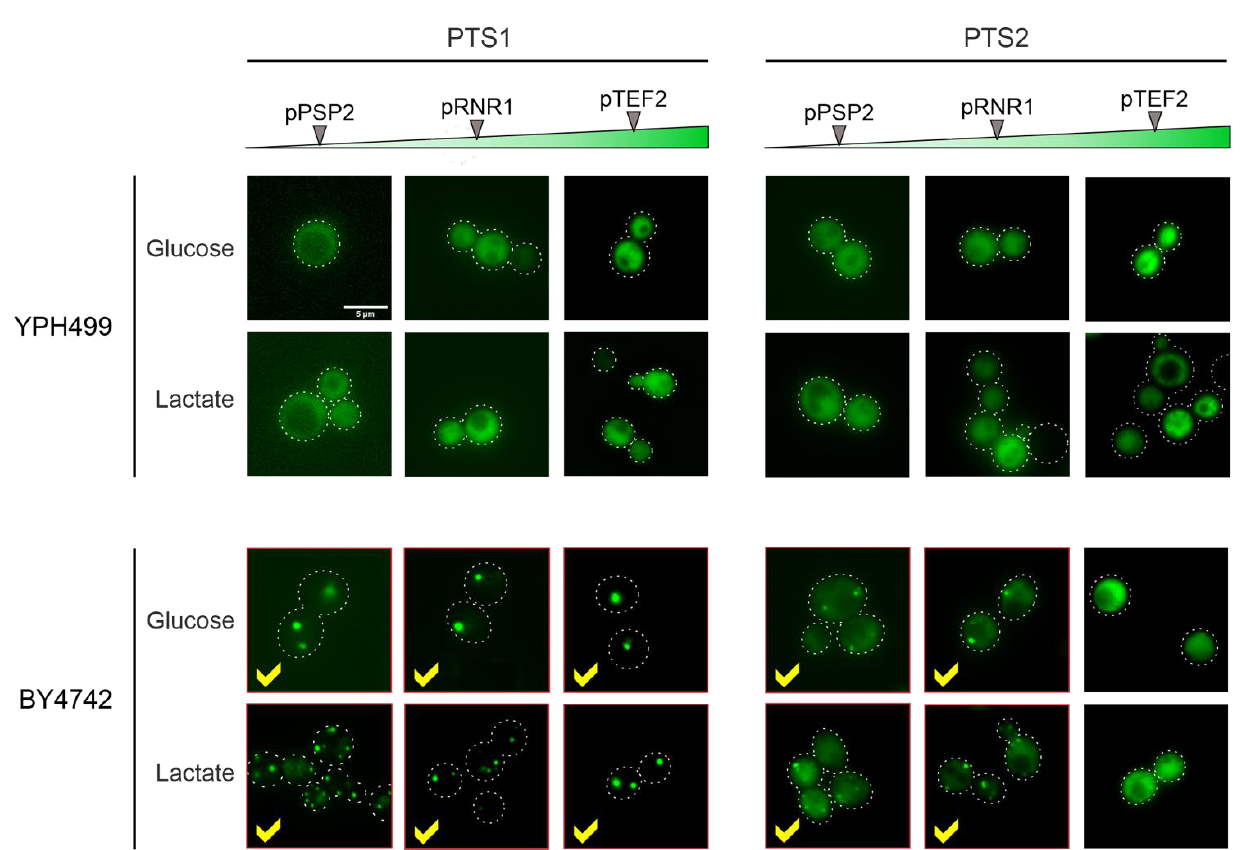
FIGURE 5: Different wild type backgrounds considerably differ in their targeting competence. Cells of YPH499 and BY4742 wild types were transformed with NeonGreen-expressing plasmids differing in promoter strength and peroxisomal targeting sequences. Cells were grown in glucose or lactate medium for the times indicated. Whereas peroxisomal targeting worked well in the BY4742 cells, the fusion proteins showed a cytosolic distribution in the YPH499 background. However, the carbon source used had no influence on the targeting, but on the number of peroxisomes per cell. Scale bar, 5